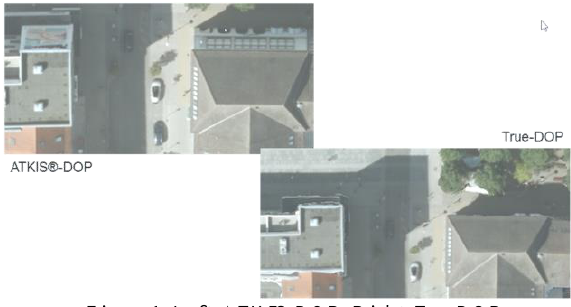
Figure 1. Left: ATKIS-DOP; Right: